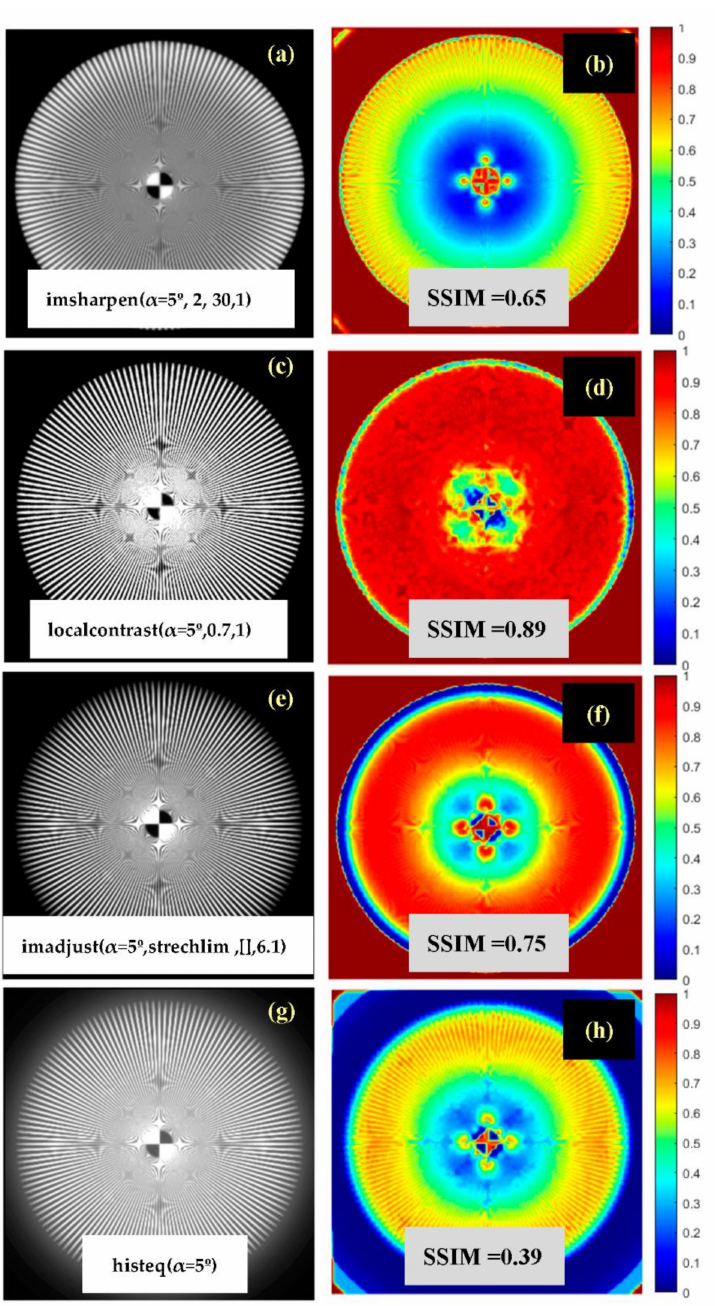
Figure 9. ( a , c , e , g ) Digitally enhanced images with popular MATLAB functions from a Siemens Star image degraded with stray-light ( α = 5º, Figure 7b). ( b , d , f , h ) Corresponding SSIM (see Section 2.2.3) maps in relation with the original undegraded Siemens Star image shown in Figure 7a. ( a ) Image enhanced with function “imsharpen” with parameters: ‘amount’ = 2, ‘radius’ = 30, ‘threshold’ = 1. ( c ) Image enhanced with function “localcontrast” with parameters: ‘edgethreshold’ = 0.7, ‘amount’ = 1. ( e ) Image enhanced with function “imadjust” with parameters: [low_in high_in] = strechlim, ‘gamma’ = 6.1, ( f ) Image enhanced with histogram equalization function “histeq”. The function parameters for “imsharpen,” “localcontrast,” and “imadjust” were optimized to achieve a maximum